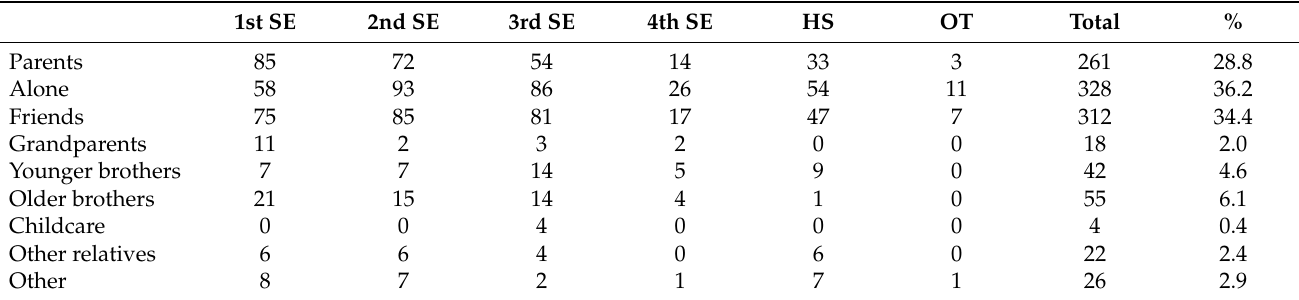
Table 6. Accompaniment of students in Secondary Education (SE), High School (HS), and Occupa- tional Training (OT). Percentages refer to the total number of students surveyed at the Secondary Education, High School, and OT levels (906).